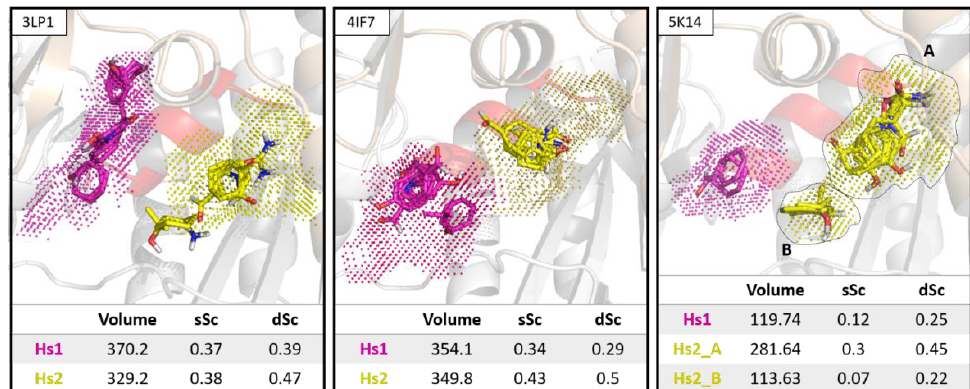
Figure 3. Overlap between FTMap probes (stick representation) and subpockets identified by DogSiteScorer (dots representation) using 3LP1, 4IF7 and 5K14 Site1 conformations. sSc: Site Score; dSc: Drug Score. Volume is expressed in Å.